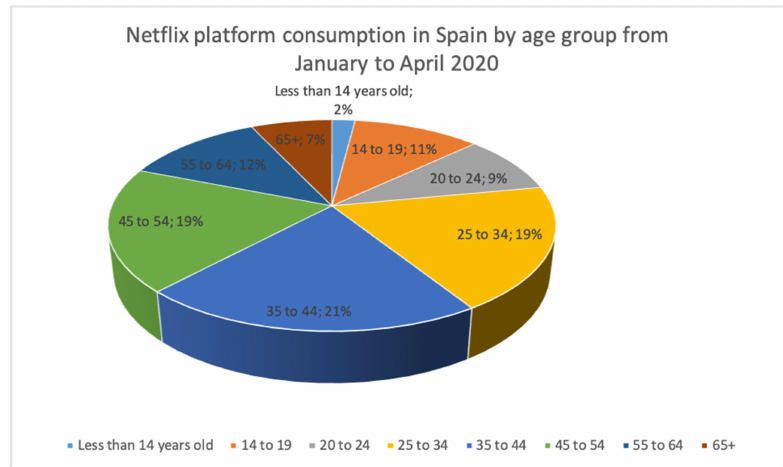
Figure 1. Netflix platform consumption in Spain according to age group, from January to April 2020. Source: Data extracted from EGM (Estudio General de Medios)